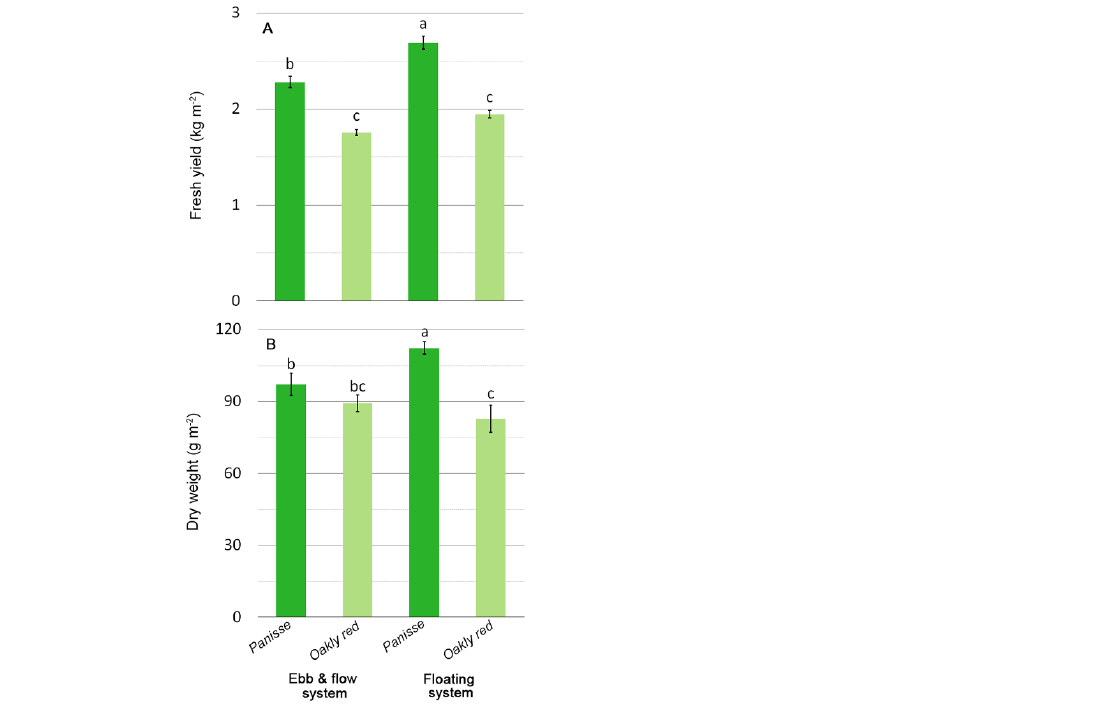
Figure 2. Effect of soilless cultivation system and genotype on yield ( A ) and dry weight ( B ) of oak-leaf lettuce grown in a greenhouse during the autumn. Vertical bars indicate ±SE of mean ( n = 6) of the observed values, with different letters significantly different according to the LSD test ( α = 0.05). Irrespective of genotype, the EF plants had a lower number, area, and height of leaves, but with a higher specific leaf area (SLA) (Table 1). The salinity of nutrient solu- tion (NS) did not affect plant growth, whereas the NS at EC 3.5 dS m − 2 provoked a slight yield reduction compared with the EC2.5 treatment associable to the decrease in leaf height, but with no further effects on the other plant morphological traits (Table 1).